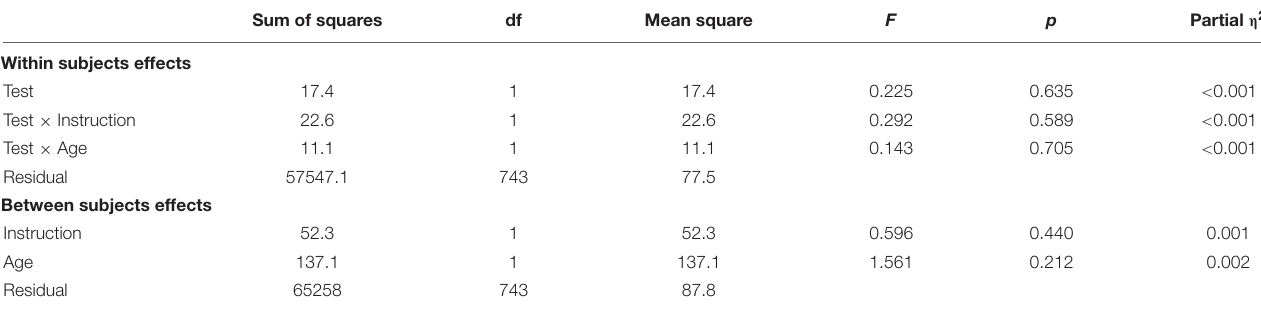
TABLE 4 | Repeated measures ANOVA: Rate of reading (test-retest differences). Sum of squares